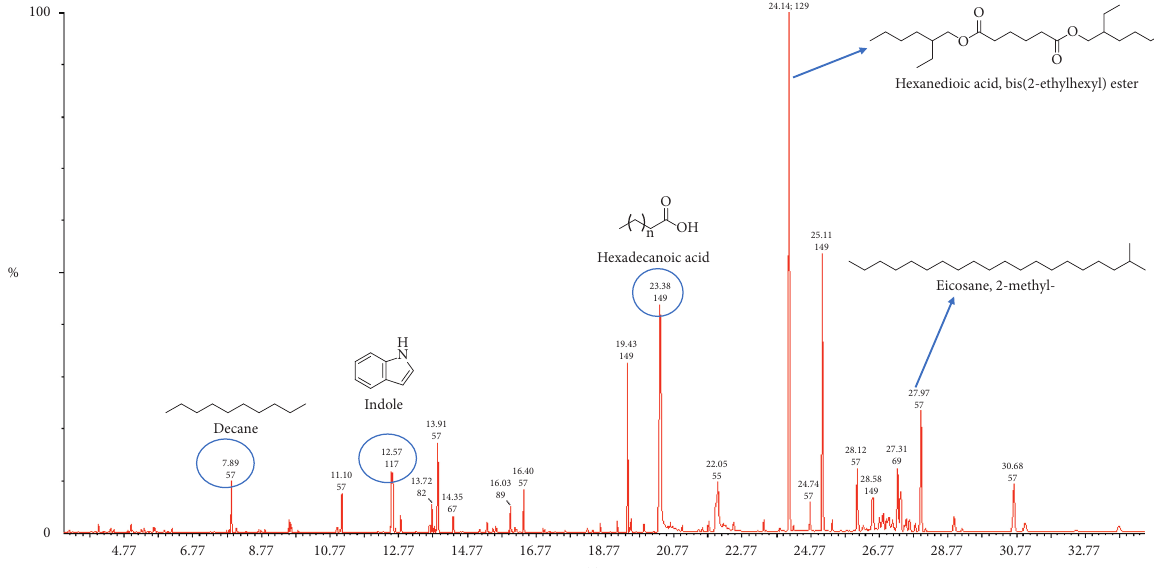
Figure 1: Total ion chromatogram (TIC) obtained from the GC-MS run of the essential oil from the leaves of Chrysophyllum albidum. Compounds were identified by comparison of MS spectra data with NIST and Wiley libraries as well as published literature. Chemical structures of some of the peaks are shown and were drawn with